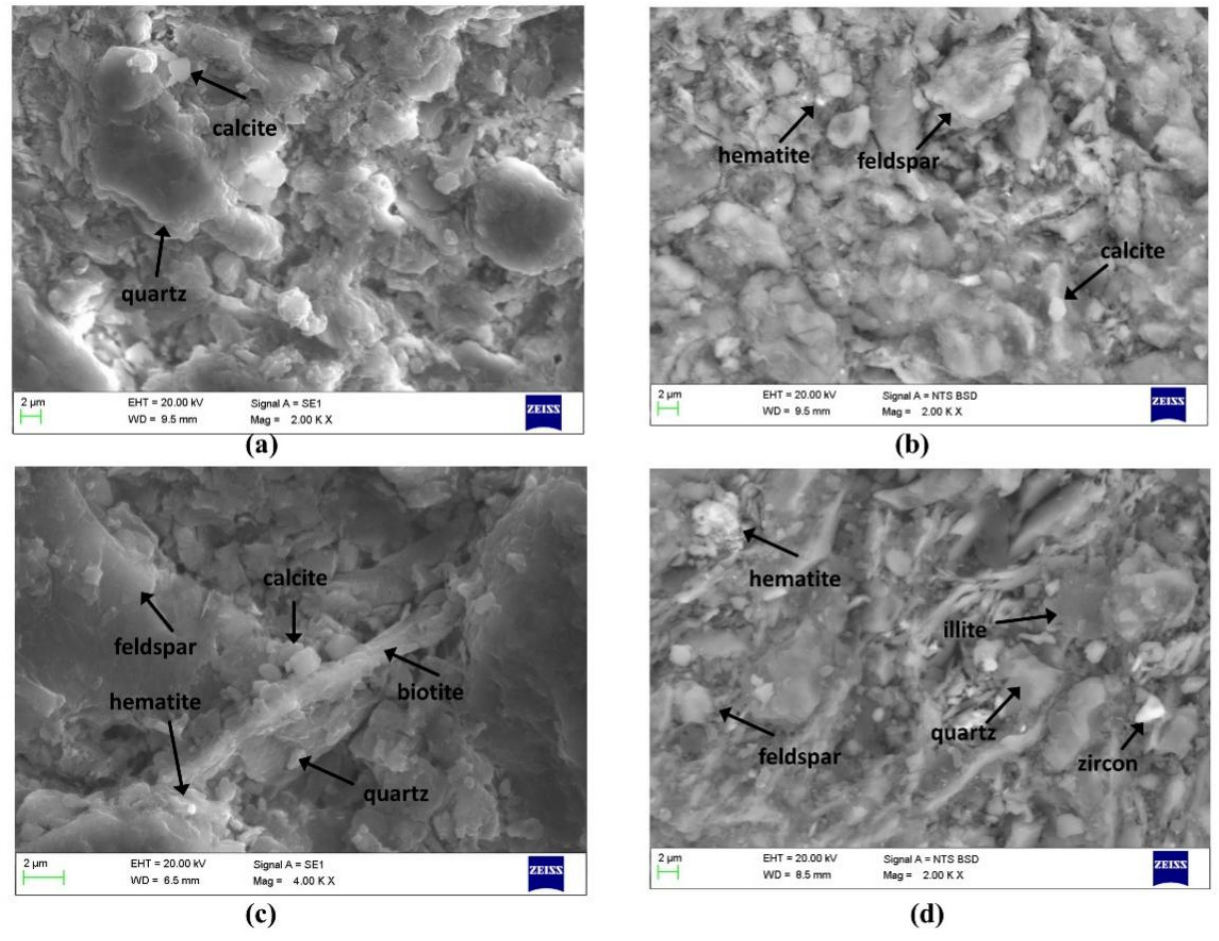
Figure 6. SEM backscattered electron mode images representative of inclusions of sample paste. ( a ) C-1; ( b ) C-8; ( c ) T-1 and ( d ) T-2. Table 3. Mineral composition of the body of Hancheng glazed tile samples.